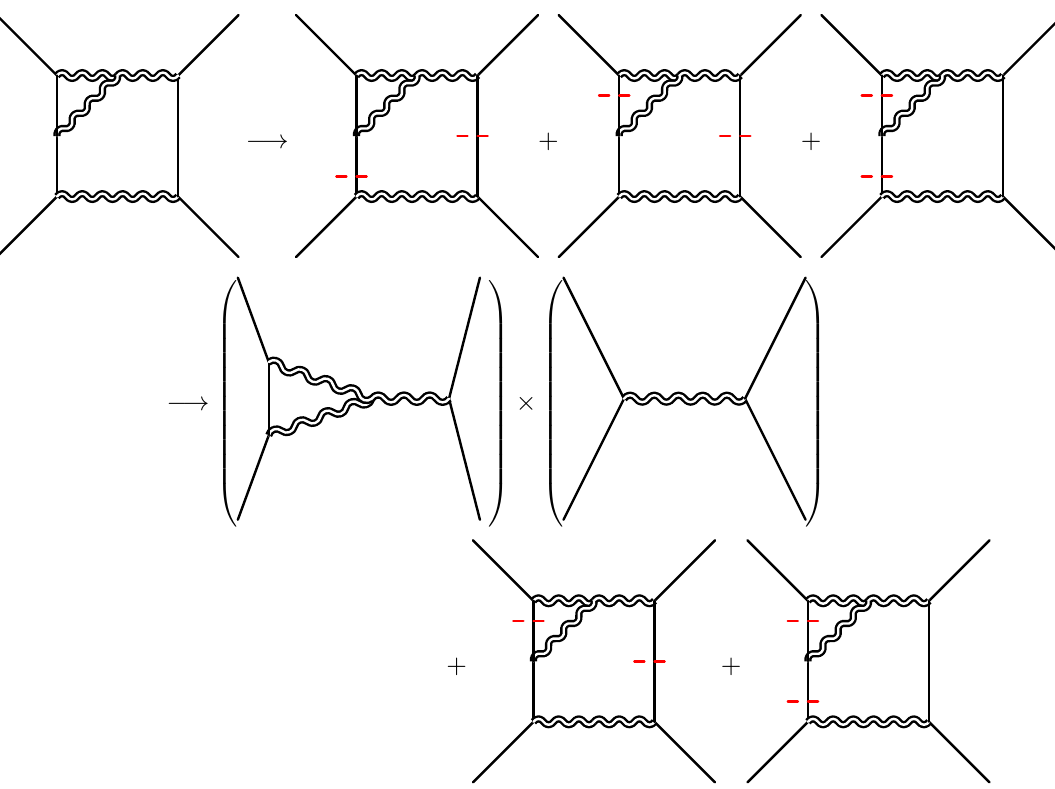
Figure 7 . Velocity cuts of the box-triangle